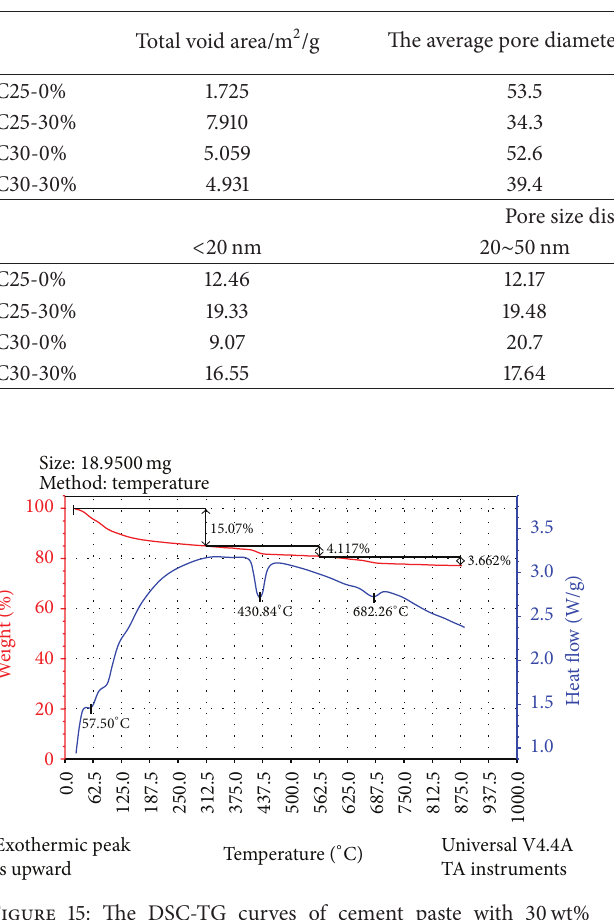
Table 6: The results of MIP test of C25 and C30.